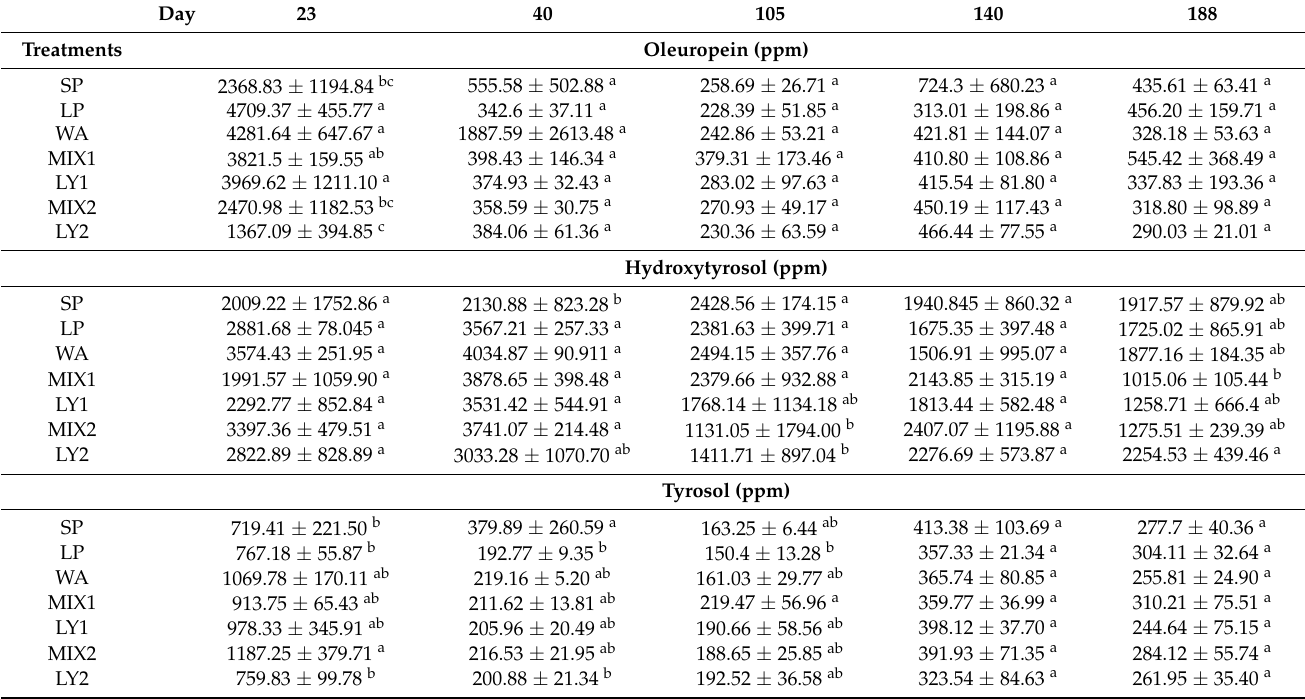
Table 4. Change in concentration of oleuropein, hydroxytyrosol and tyrosol in the pulp of olives during fermentations, measured by HPLC analysis. Different letters indicate significant differences (LSD) among the different treatments ( p ≤ 0.05) within the same sampling time. Data are the averages from three replicates ± standard